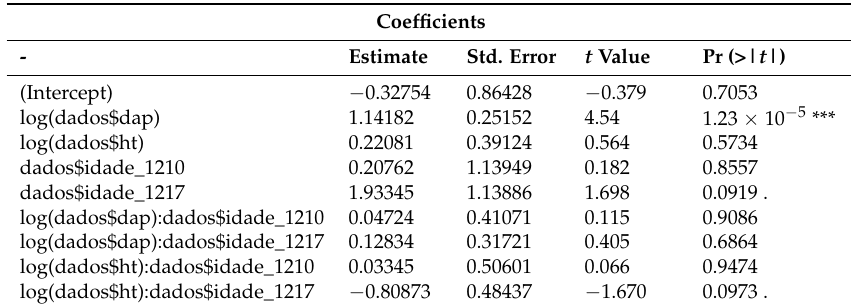
Table A18. R software output table with significance values resulting from ANCOVA for CFM using C12 as reference for comparison with C 10 and C 17.